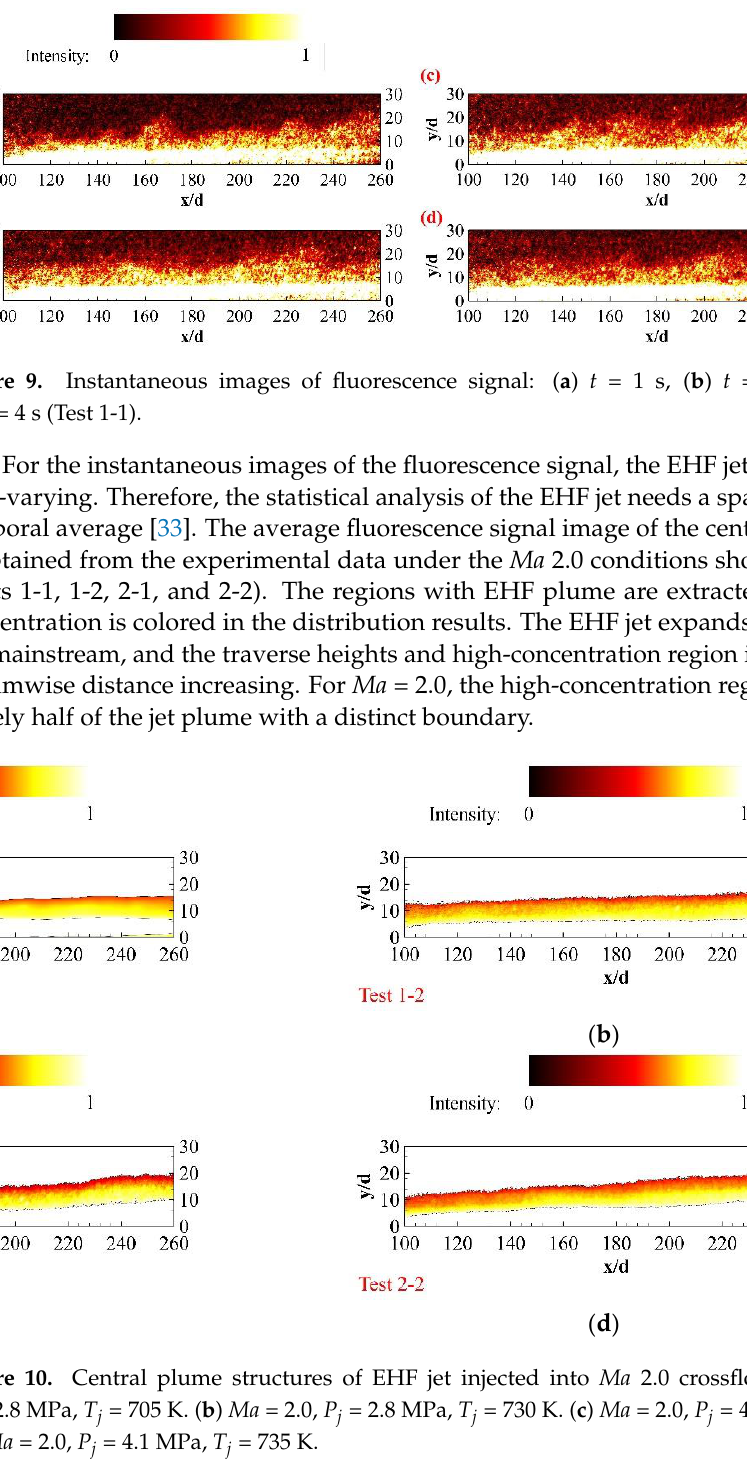
( f ) Figure 8. Morphology of supercritical jet in supersonic crossflow: ( a ) t = 2 μ s, ( b ) t = 4 μs, ( c ) t = 6 μs, ( d ) t = 8 μs, ( e ) t = 10 μs, ( f ) t = 12 μs (Case U3 -2). 4.2. Spatial Distribution The central plane distribution of the EHF jet plume is investigated by the acetone